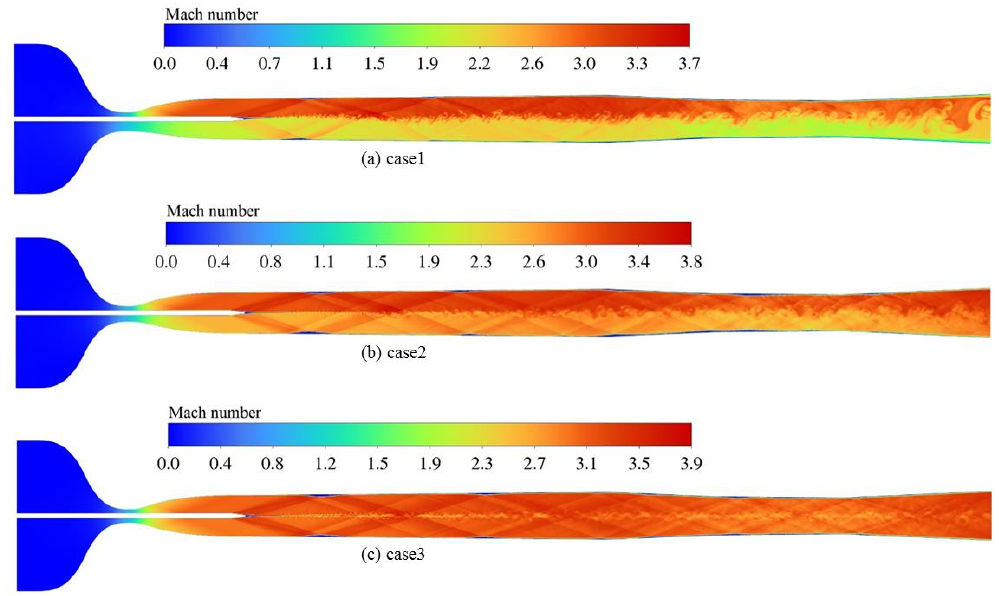
Figure 8. Mach number contours of the full flow field.